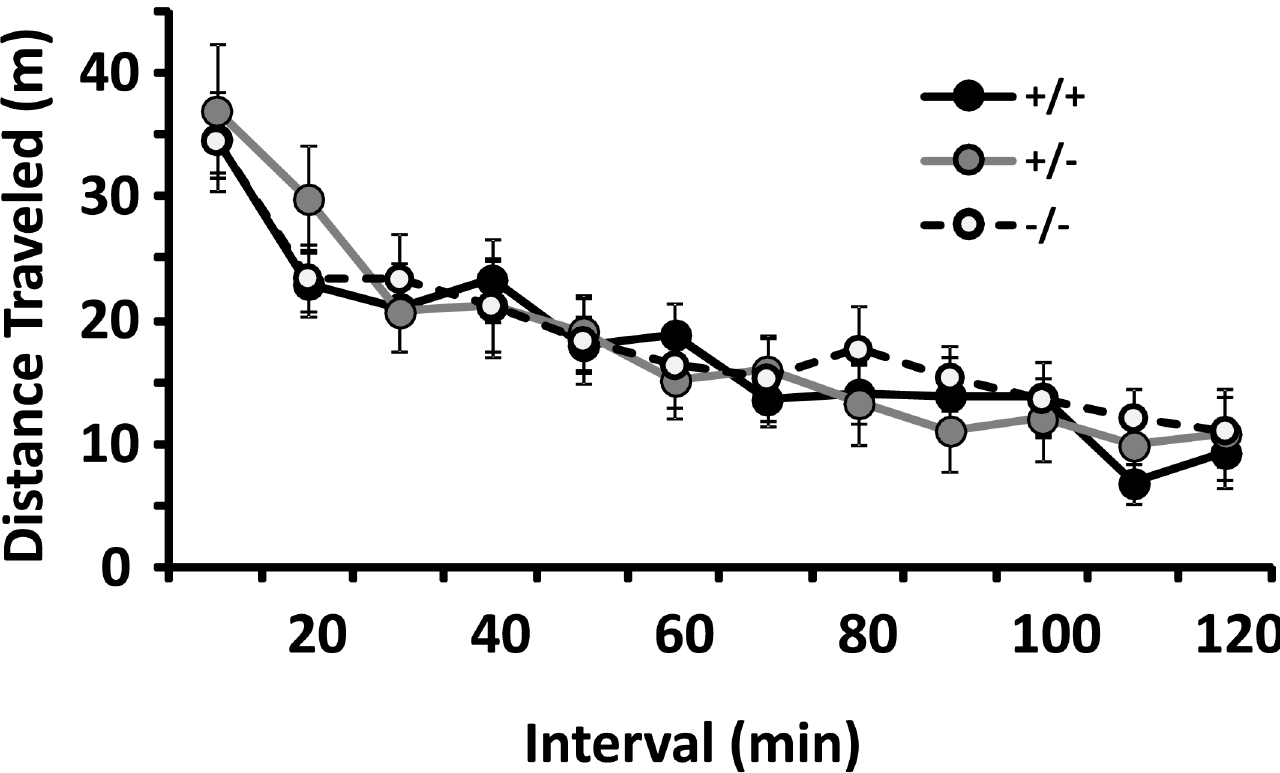
Fig 3. Locomotion and habituation in a novel 42 x 42 cm chamber: no significant differences between mice with different CSMD1 genotypes. Values are mean +/- SEM of the number of meters traveled when mice were exposed for the first time to the 42 x 42 cm apparatus (n = 10/genotype, ANOVA p =